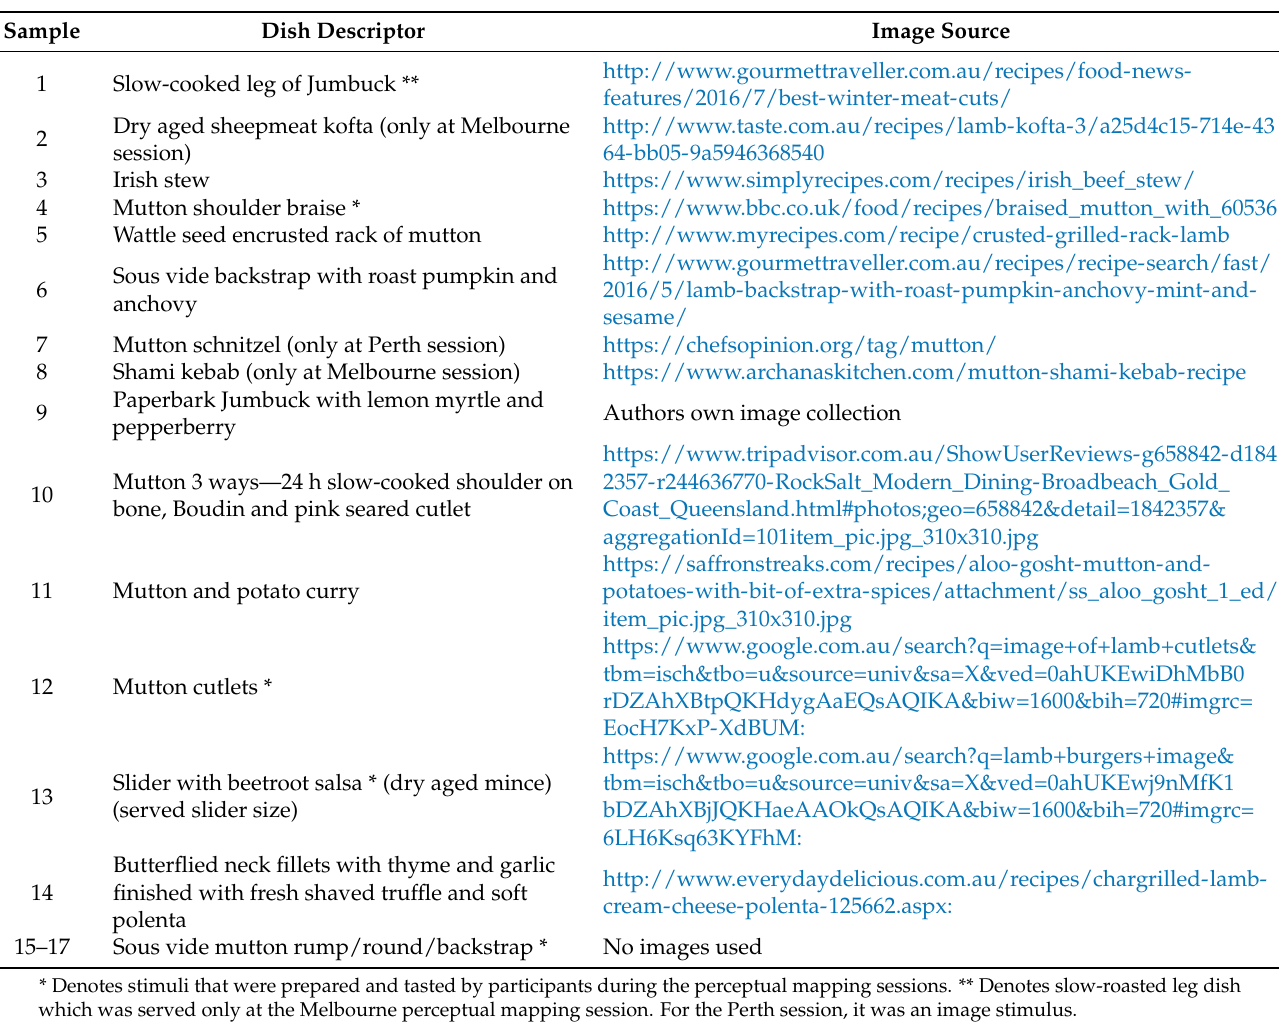
Table 2. Stimuli description and source of images used for product stimuli.